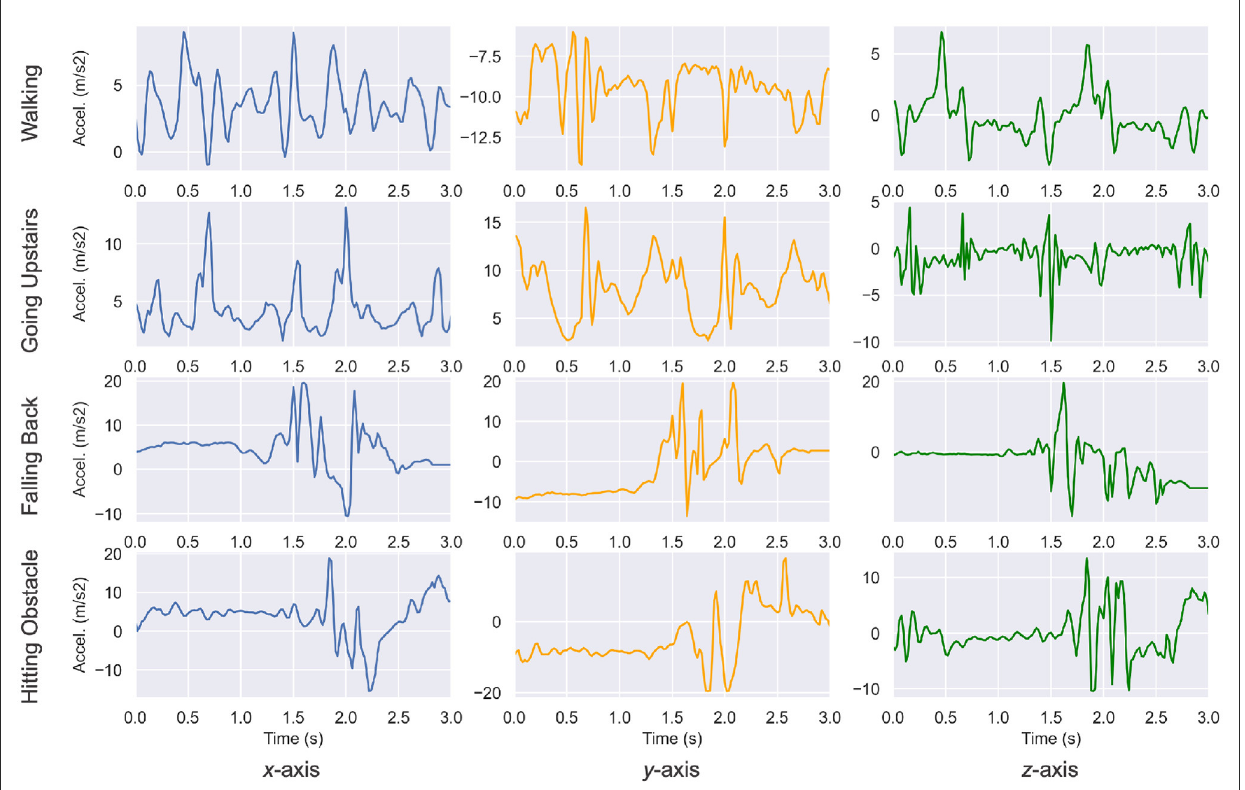
FIGURE1 Acceleration segments from the UniMiB-SHAR dataset (14). Patterns and amplitudes variations are significantly different across various activities. For example, the walking activity features low amplitude and periodic patterns, whereas the falling back activity features a sudden burst of